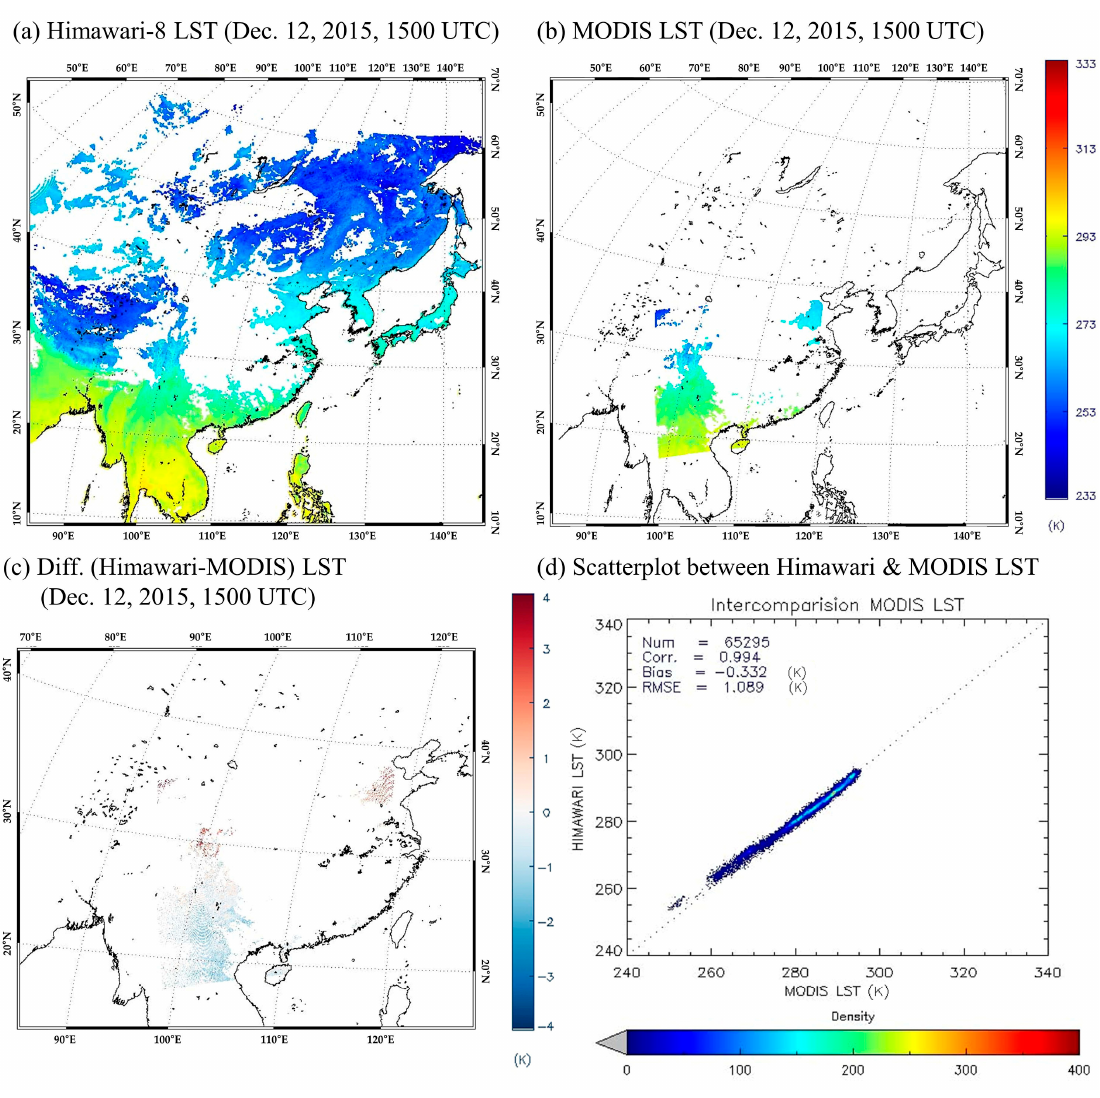
Figure 7. Spatial distribution of ( a ) Himawari-8 LST, ( b ) MODIS LST, ( c ) their differences, and ( d ) scatter plot between Himawari-8 and MODIS LST for December 12, 2015, 1500 UTC.